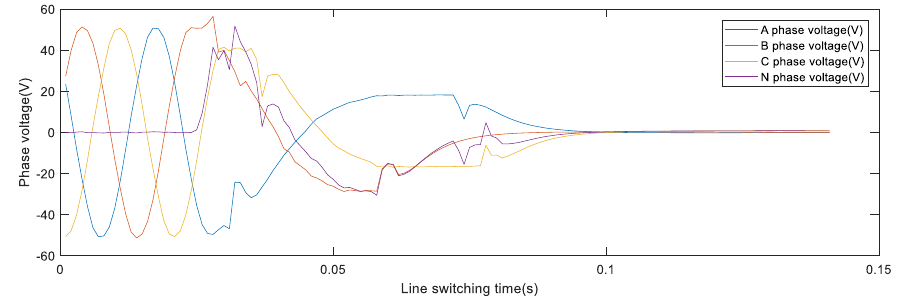
Figure 9. Transient voltage fluctuation of A, B, C, and N in line cut.